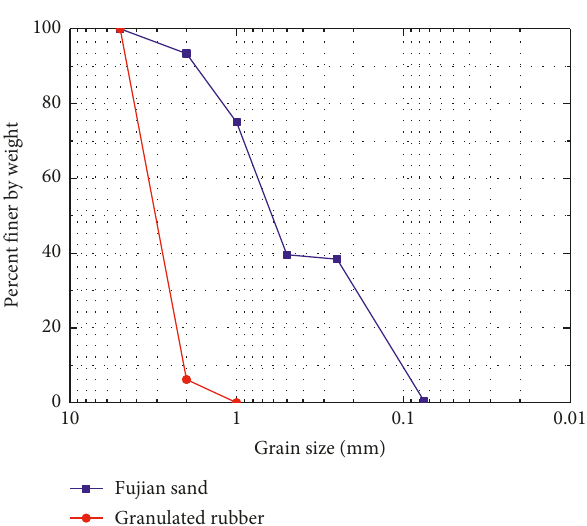
Figure 1: Grain size distribution of the Fujian sand and granulated rubber material used in the tests.